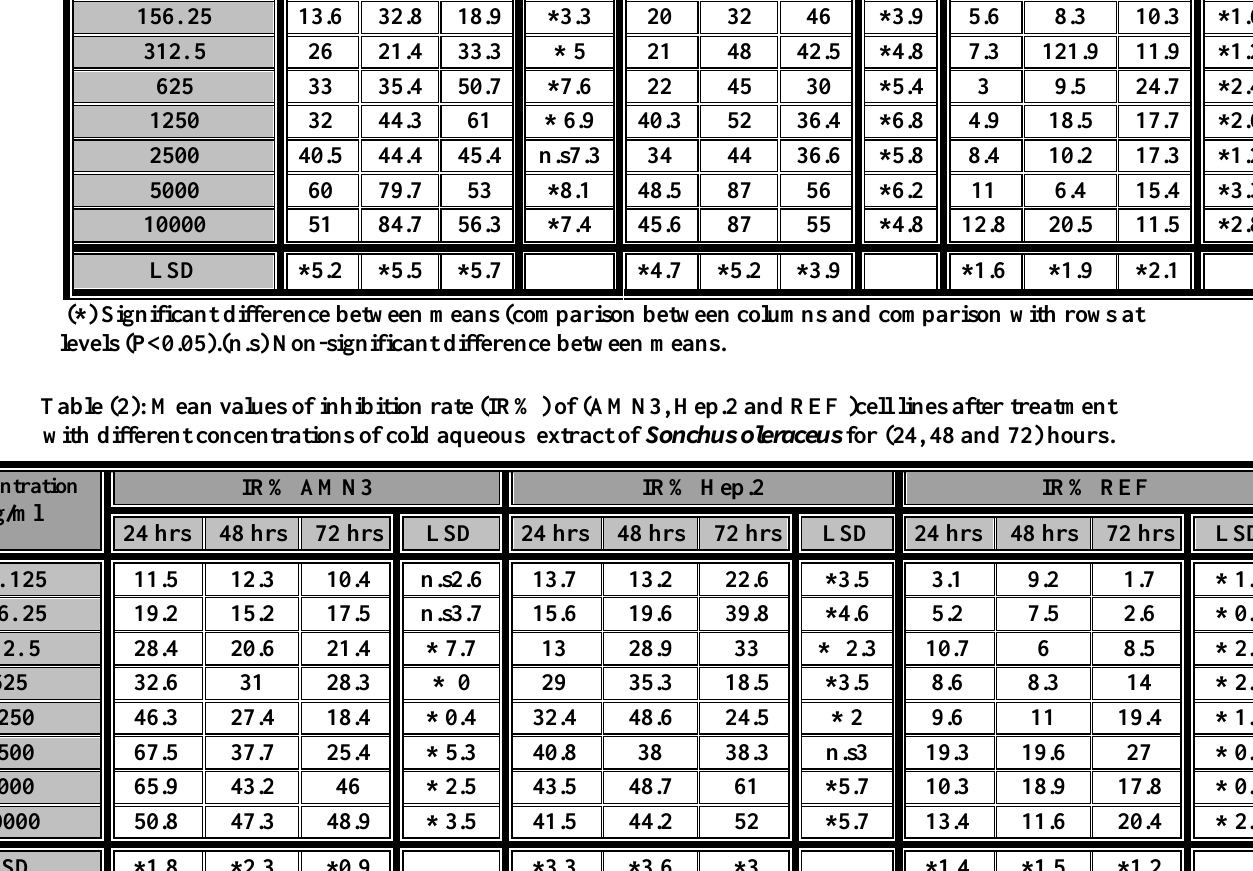
(*) Significant difference between means (comparison between columns and comparison with rows at levels (P<0.05). (n.s) Non-significant difference between